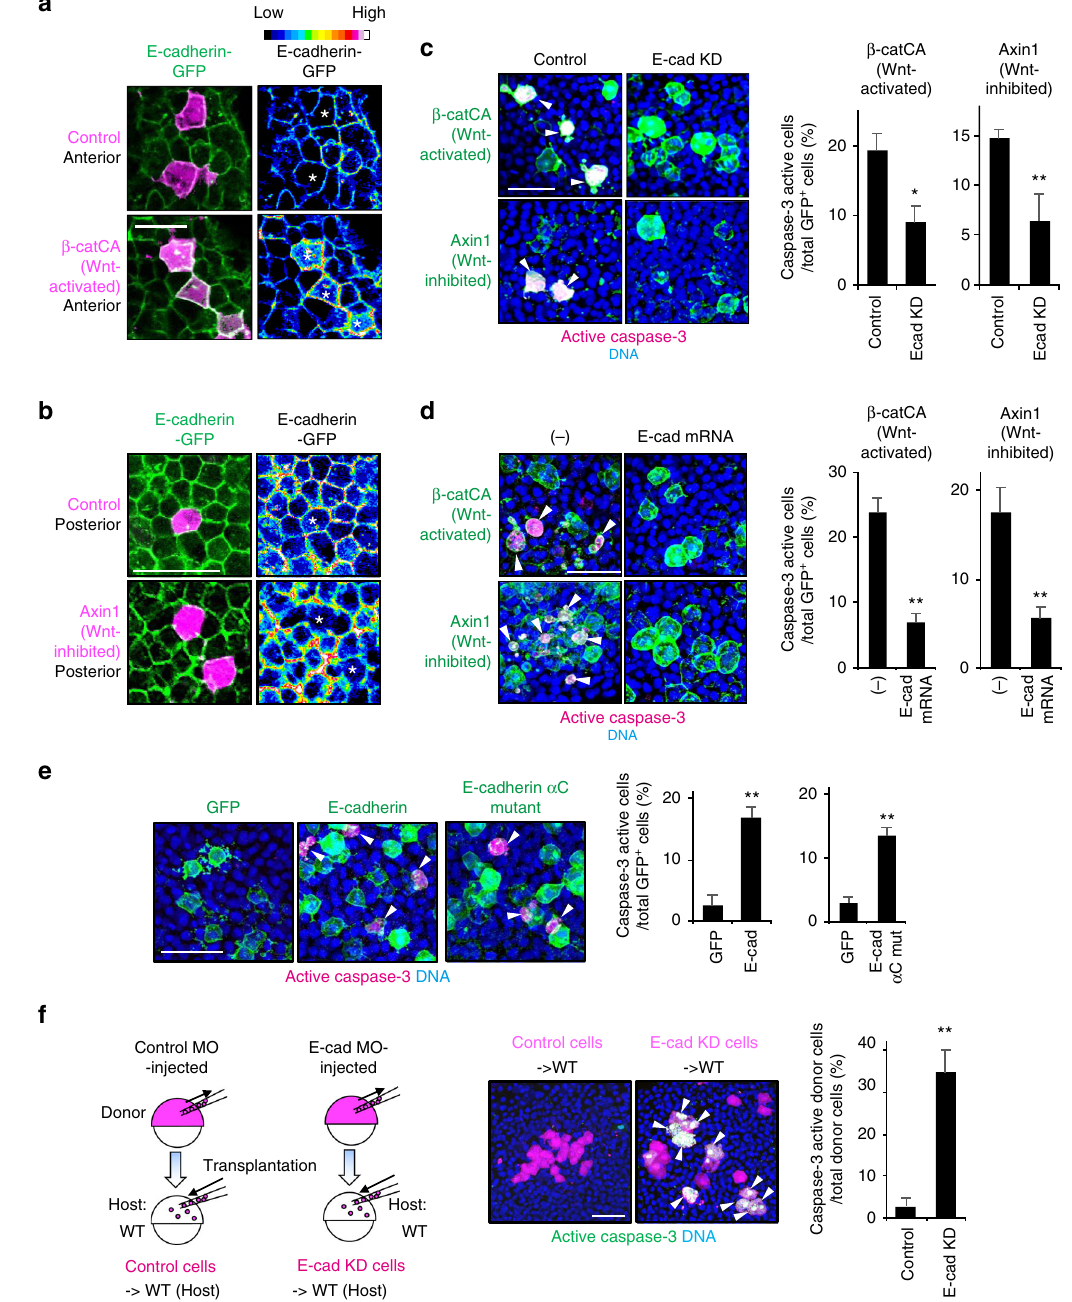
Fig. 4 Cadherin is involved in un fi t cell sensing. a , b Mosaic un fi t abnormal Wnt/ β -catenin-activity cell introduction changes exogenous E-cadherin levels in zebra fi sh embryos. Confocal images showing embryos injected with E-cadherin-GFP mRNA (green) and mosaically introduced with mKO2 alone- expressing control cells or mKO2 and β -catCA- or Axin1-overexpressing cells (magenta). Right panels show fl uorescence intensity of E-cadherin-GFP. Scale bar, 50 μ m. c , d Partial E-cadherin knockdown ( c ) or E-cadherin overexpression ( d ) blocks β -catCA- or Axin1-overexpressing cell apoptosis. Confocal images showing whole-mount immunostaining of active caspase-3 (magenta) in mosaic embryos expressing membrane GFP ± β -catCA or Axin1 (green) and injected with low dose E-cadherin MO (E-cad KD) or E-cadherin mRNA. Arrowheads indicate caspase-3-active cells. Scale bar, 50 μ m. Graphs show the means± SEM ( n = 8 or more embryos, two independent experiments) of GFP + ( β -catCA, Axin1) caspase-3 active cell frequencies (right). ** p < 0.01, * p < 0.05 ( t test). e Cells with un fi t high E-cadherin levels undergo apoptosis in mosaic embryos. Confocal images showing whole-mount immunostaining of active caspase-3 (magenta) in mosaic embryos expressing membrane GFP ± E-cadherin or its mutant (green). Arrowheads indicate caspase-3-active cells. Scale bar, 50 μ m. Graphs show the means ± SEM ( n = 5 or more embryos, two independent experiments) of GFP + caspase-3-active cell frequencies (right). ** p < 0.01 ( t test). f Cells with un fi t low E-cadherin levels undergo apoptosis in mosaic embryos. E-cadherin partial knockdown (E-cad KD) cells or control cells (magenta) were transplanted into wild-type embryos. Confocal images showing whole-mount immunostaining of active caspase-3 (green) in mosaic embryos. Arrowheads indicate caspase-3-active cells. Scale bar, 50 μ m. Graph shows the means ± SEM ( n = 7 or more embryos, two independent experiments) of GFP + caspase-3-active cell frequencies (right). ** p < 0.01 ( t test). See also Supplementary Fig. 4